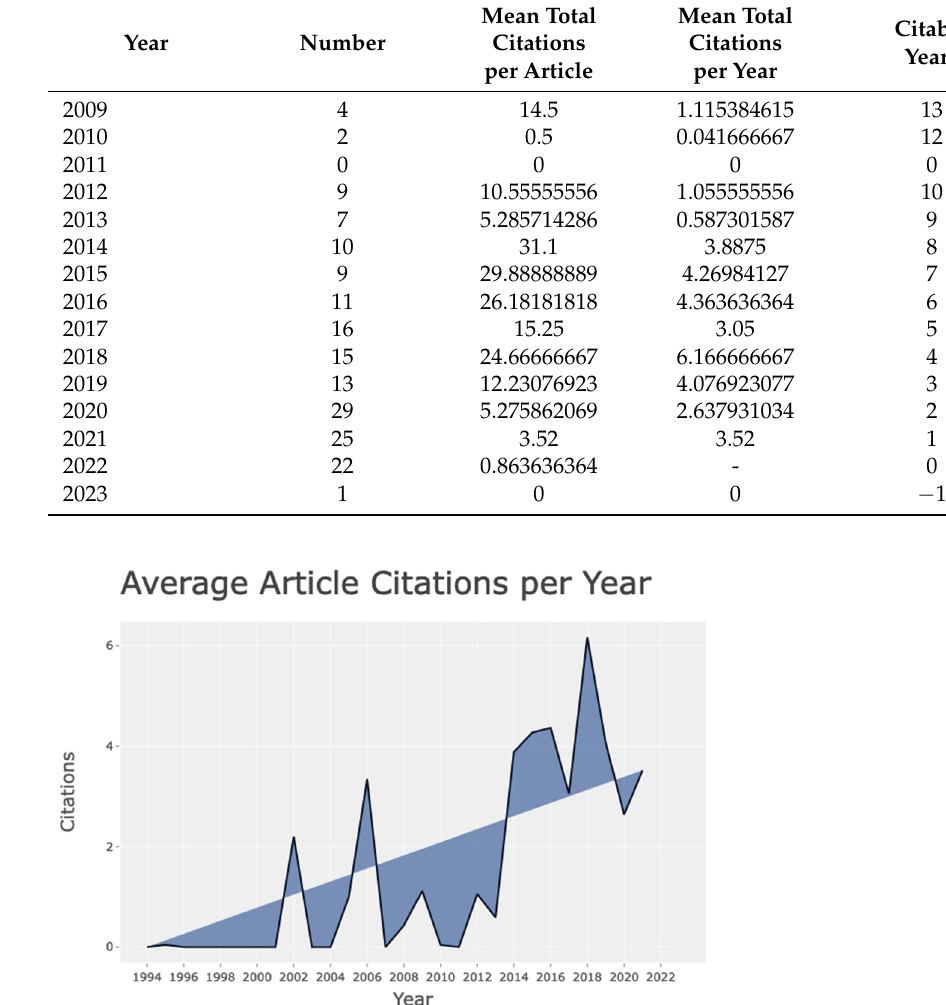
Figure 11. Main authors’ collaboration network.